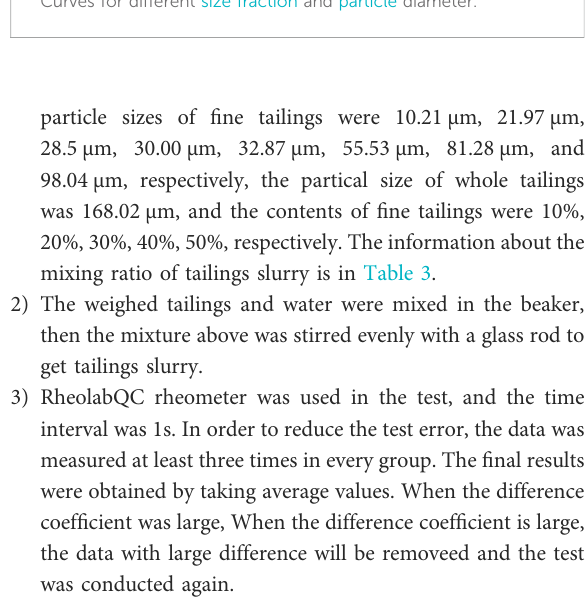
FIGURE 3 Curves for different size fraction and particle